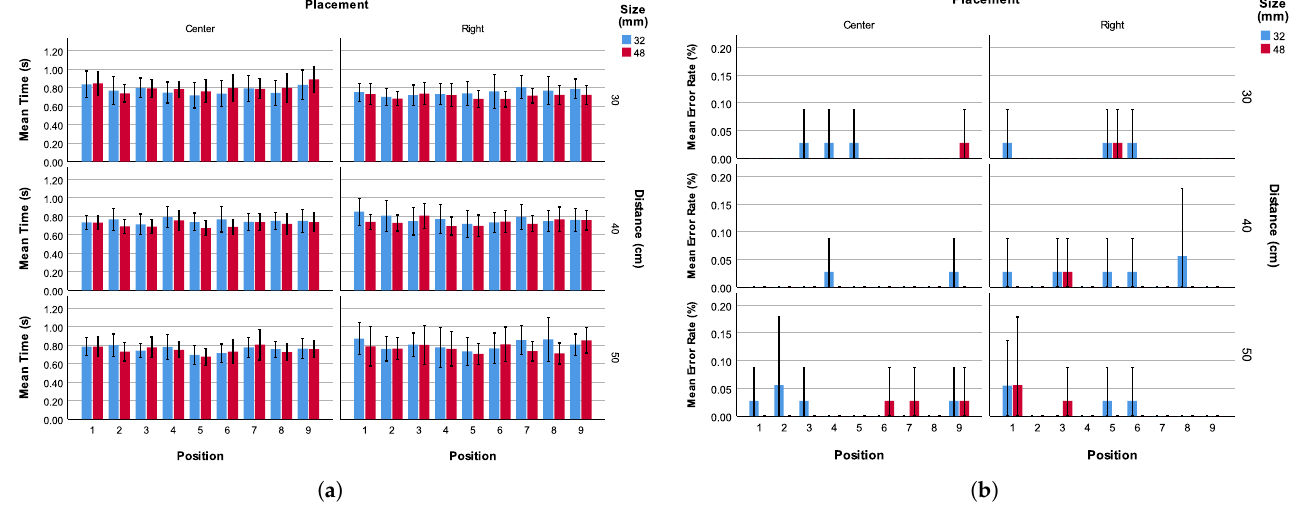
Figure 3. Mean selection time and error rate. In this and later charts, error bars represent 95% confidence intervals. ( a ) Mean selection time; ( b ) Mean error